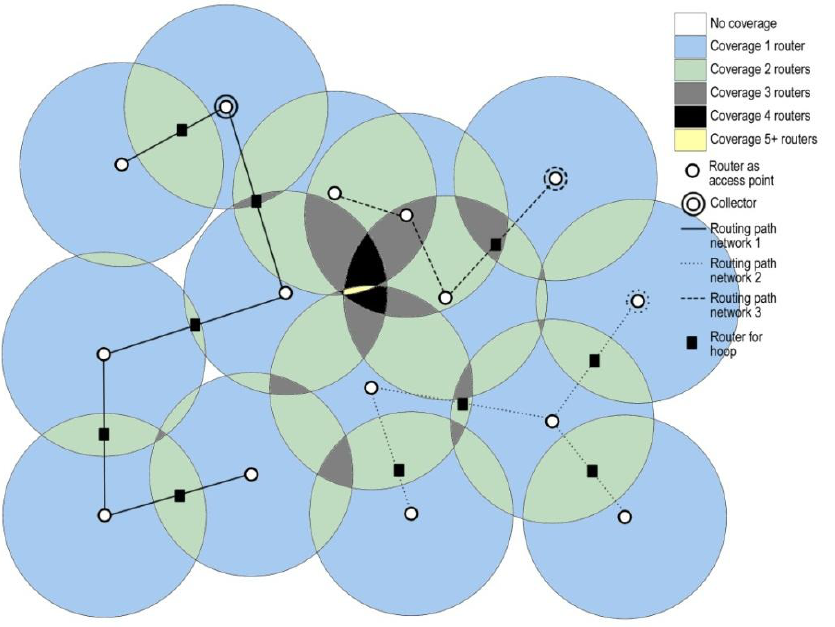
Figure 1. Heterogeneous wireless sensor network with three networks based on sensor routers of different technologies, giving different quality of service, and ready to provide support to mobile wireless